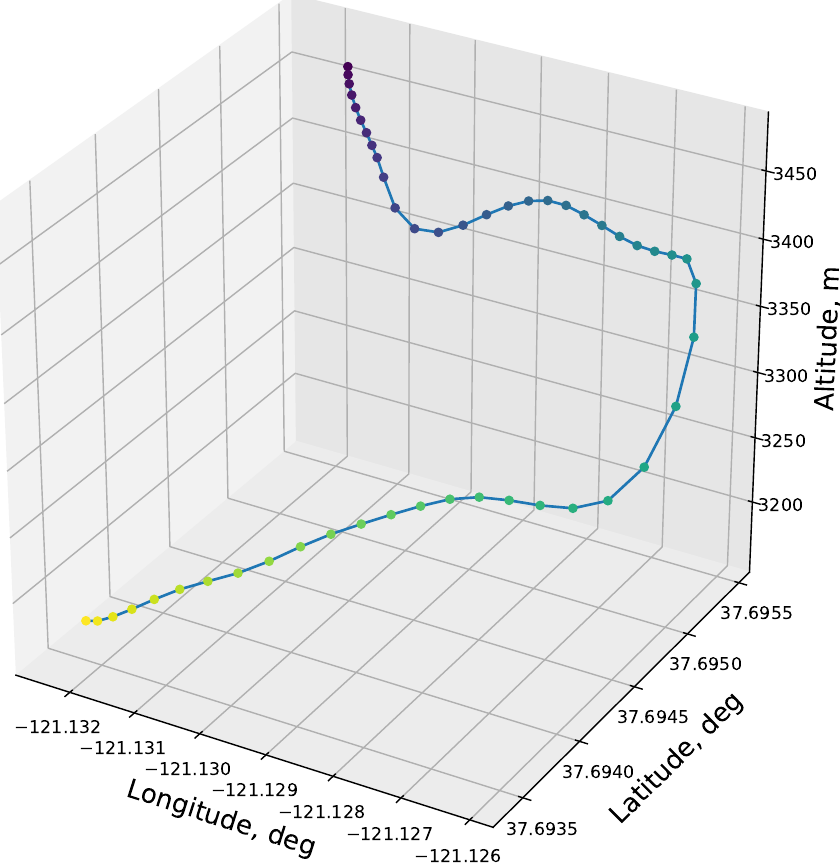
Figure 1. An example of a part of the trajectory for the generated dataset. The obtained values of geographic coordinates were converted into values for the Universal Transverse Mercator (UTM). In addition, absolute coordinates were converted into displacement values ∆ x k = x k − x ( at k step relative to k − 1 step, for all k , during k − 1 ) data preparation. The duration of each experiment was 1000 s, with intervals between measurements of 1 s. The initial flight altitude was assumed to be 5000 m, and the initial speed was 250